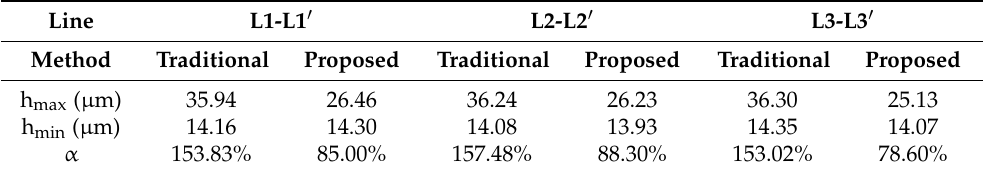
Figure 7. The thickness distributions of three dotted lines (L1-L1’, L2-L2’ and L3-L3’) after the use of two methods. ( a ) The thickness curves at the locations of L1-L1 ′ ; ( b ) the thickness curves at the locations of L2-L2 ′ ; ( c ) the thickness curves at the locations of L3-L3 ′ . Table 3. Difference in α between two methods.